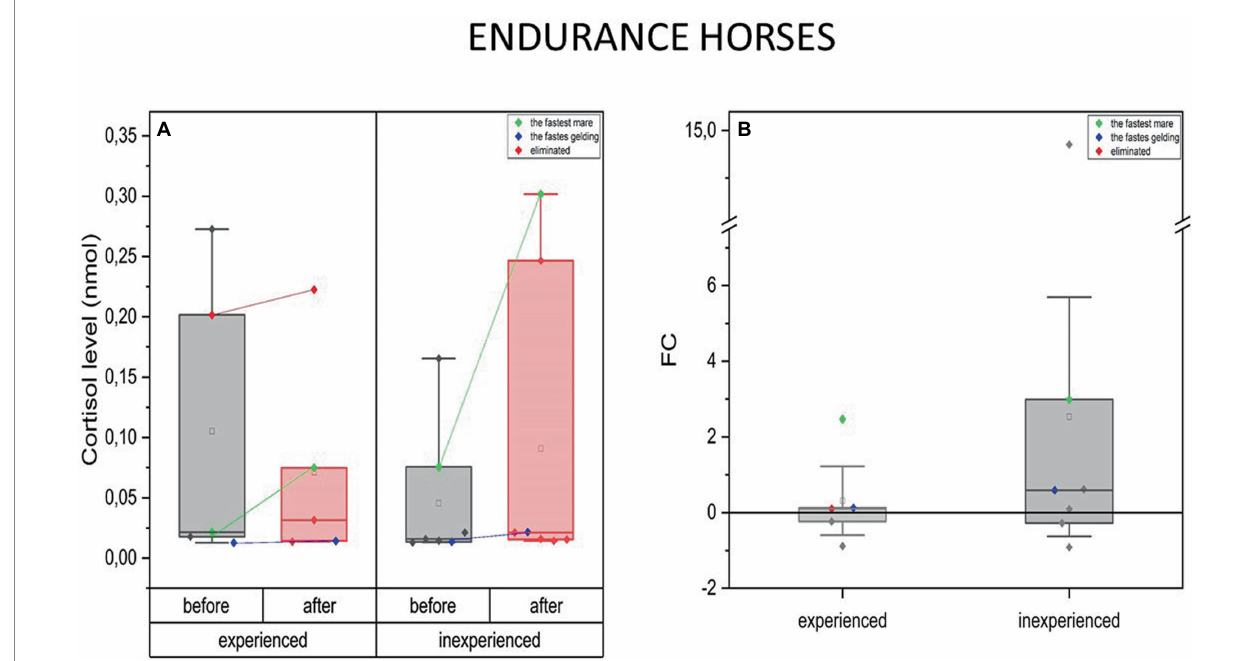
FIGURE 4 Changes in cortisol plasma concentration upon training in experienced ( n = 5) and inexperienced ( n = 7) endurance horses. Colored data points indicate the fastest mare (green), the fastest gelding (blue), and the eliminated gelding (red). Box plots (IQR, mean and median; whisker range within 1.5 IQR) are expressed as differences in molar plasma concentration (A) and fold change (FC) (B) .